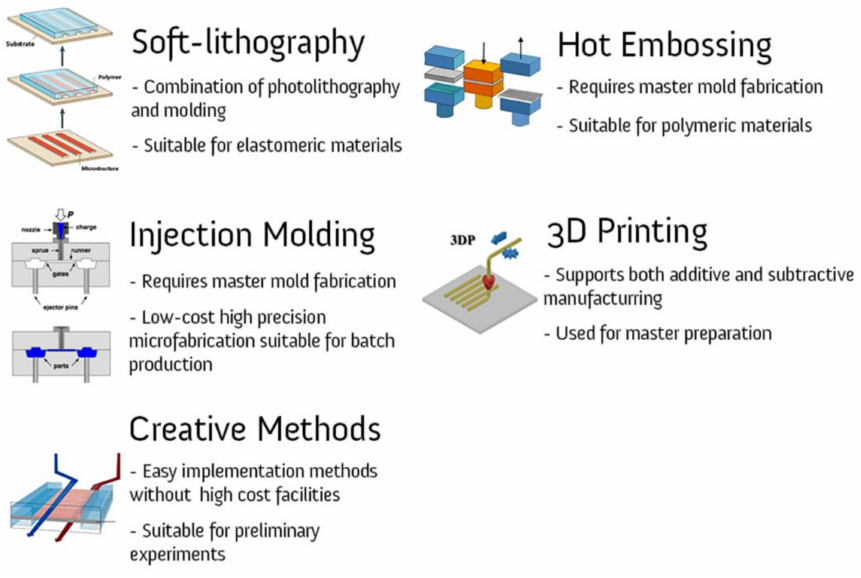
Figure 7. OOC microfabrication methods, including rapid prototyping (3D printing) and batch production (injection molding) methods. Table 3. Comparison of different microfabrication techniques